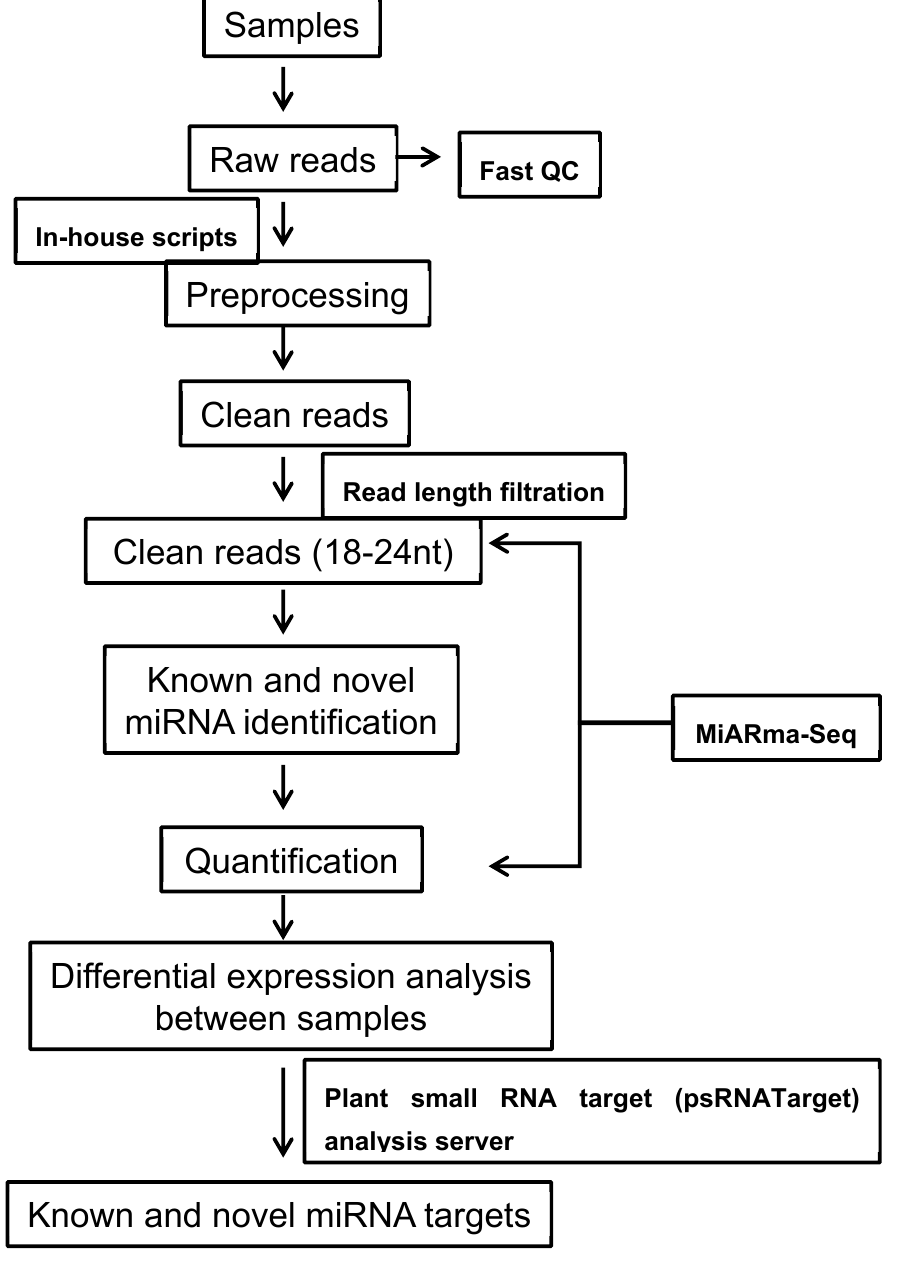
Figure 9. Bioinformatics workflow followed for analysis of the miRNAs. QC: quality check